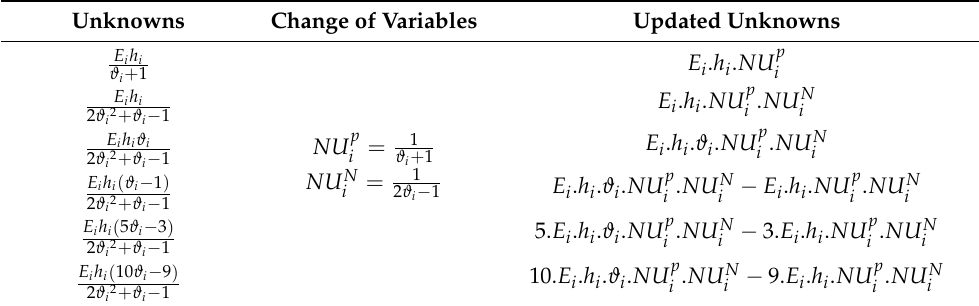
Table 2. Unknown variables before and after the proposed changes in